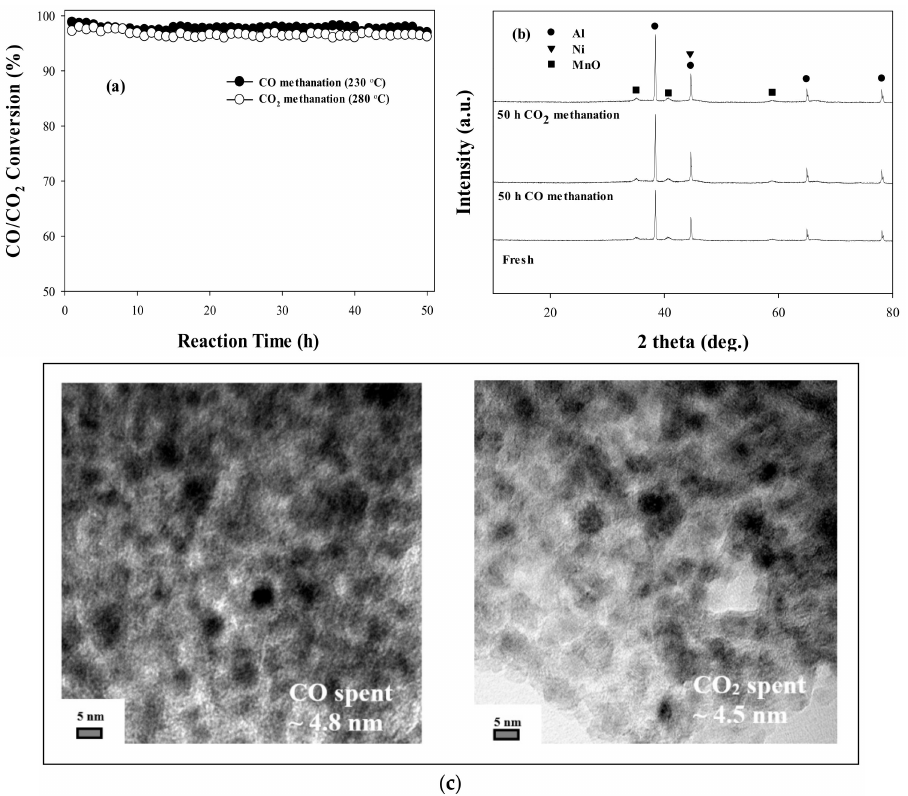
Figure 7. ( a ) Stability test for Ni / Al@MnAl 2 O 4 (DP) for CO and CO 2 methanation during 50 h, ( b ) XRD patterns of fresh and spent catalysts, ( c ) HRTEM images of spent catalysts. Reaction conditions: 1 mol.% CO (or CO 2 ), 50 mol.% H 2 , 49 mol.% He, F / W = 1000 mL / min / g cat .